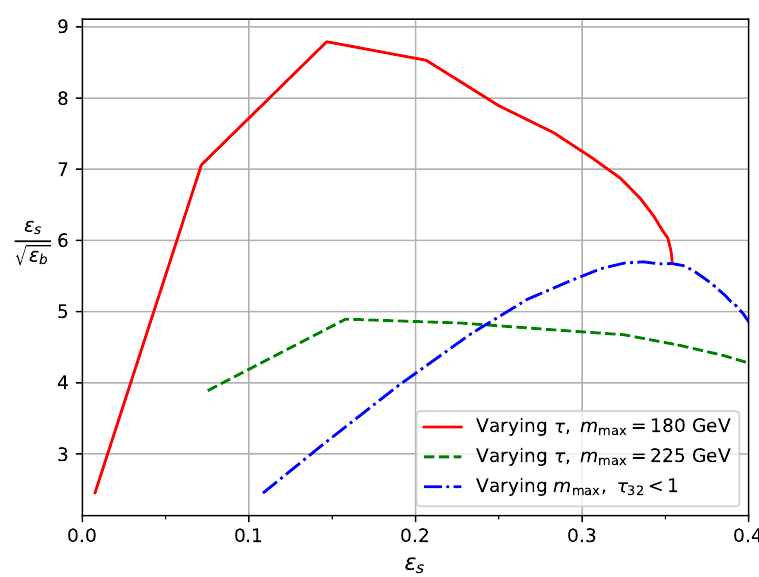
Figure 11. Signal significance against efficiency for three variations on the tagging procedure. All jets are groomed with mMDT and tagged with Y m -Splitter. Either τ or m max is varied with a fixed cut placed on the other. The samples were produced using Pythia with hadronisation and UE activated.